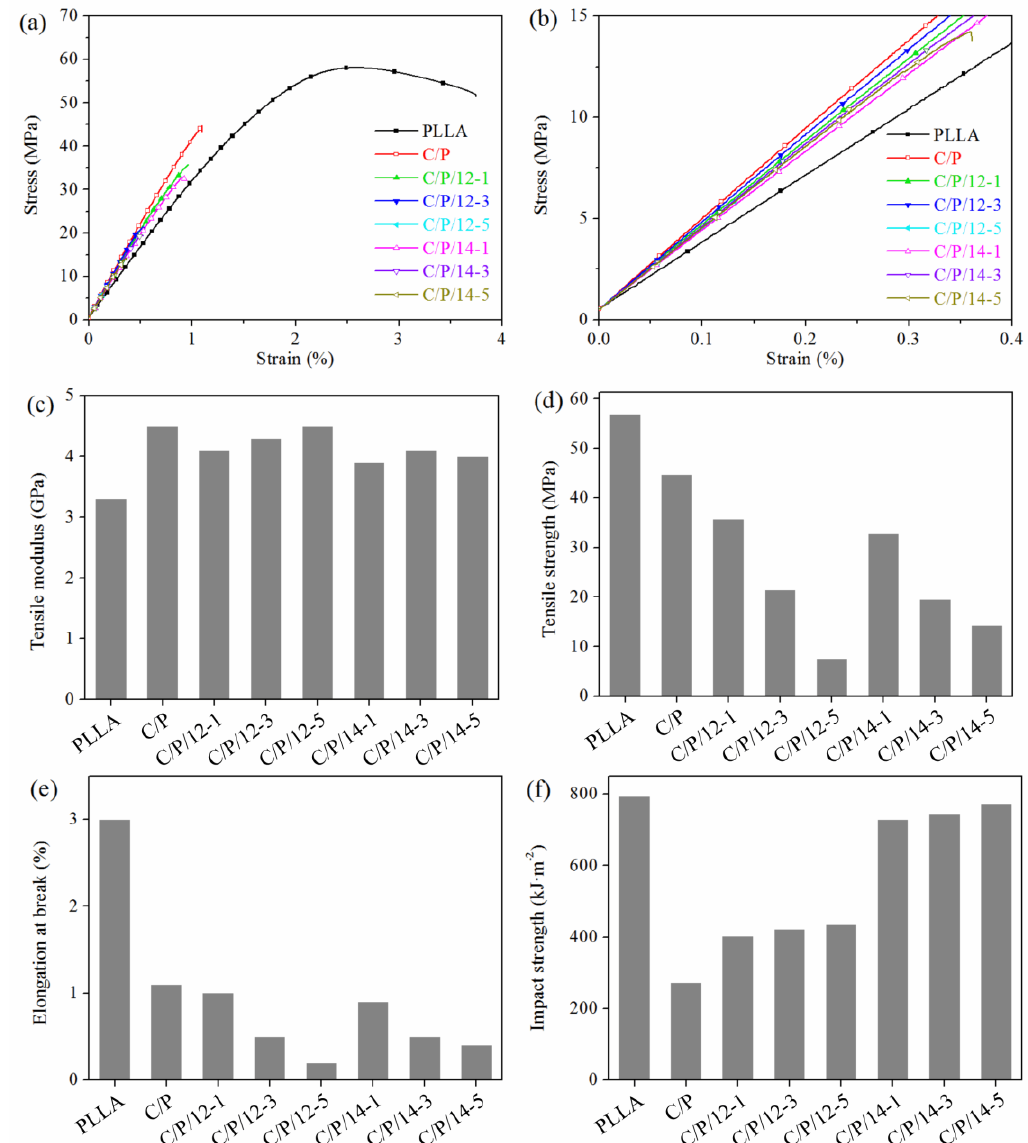
Figure 2. Mechanical properties of PLLA, C/P blend, and the composites: ( a ) representative tensile strain – stress curves, ( b ) tensile strain – stress curves in the range of 0 – 0.4% strain, ( c ) tensile modulus, ( d ) tensile strength, ( e ) elongation at break, and ( f ) notched impact strength.